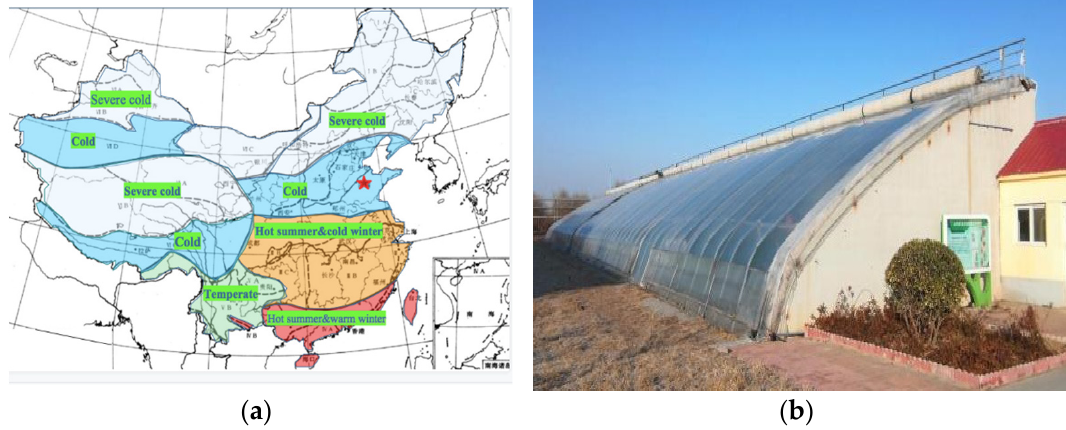
Figure 7. The climate location of Jinan and an external photograph of the solar greenhouse. ( a ) The climate location of Jinan city and ( b ) The external photograph of the solar greenhouse.